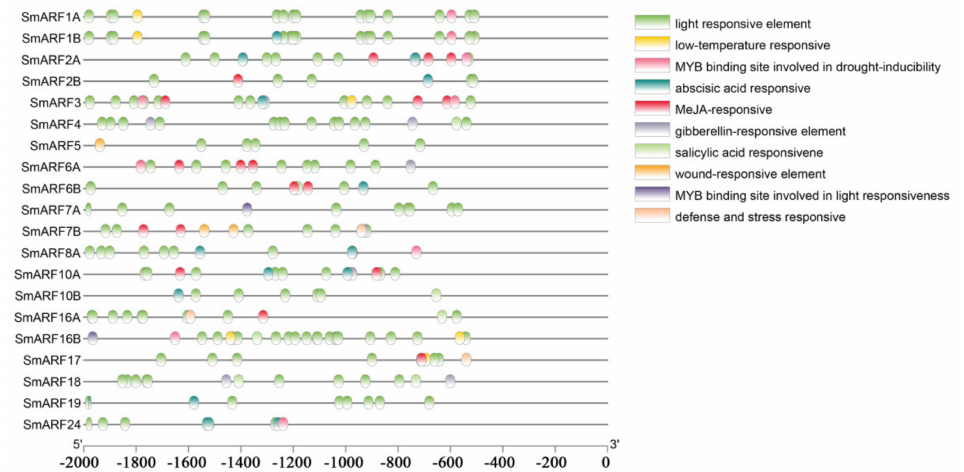
Figure 4. Cis–acting regulatory elements upstream of auxin response factor genes in eggplant ( Solanum melongena ). The presence of cis–acting elements in a 2000–bp sequence upstream of the ATG start codons was assessed using PlantCARE. The horizontal scale indicates promoter length.